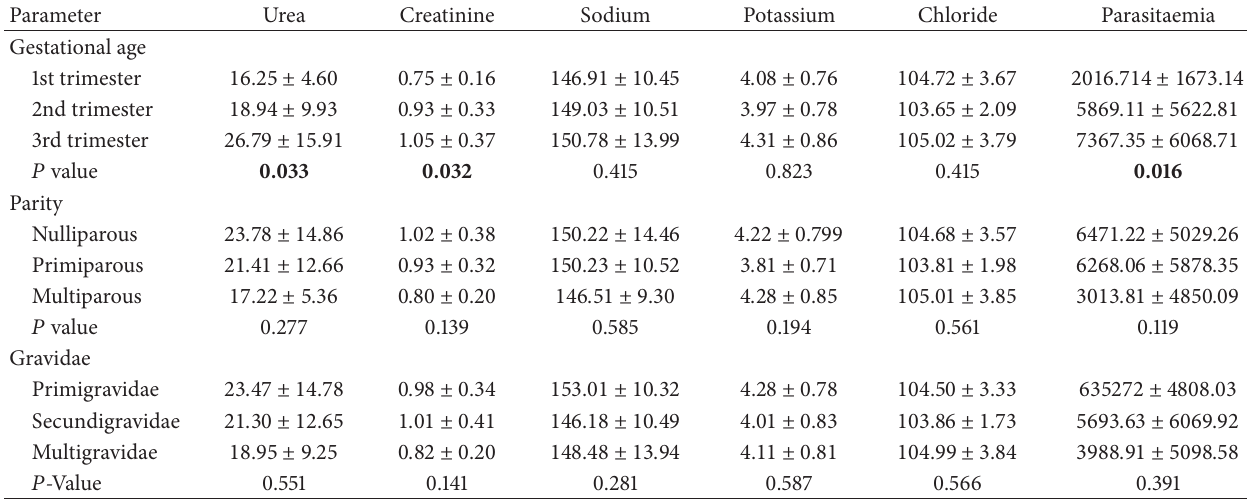
Table 3: Biochemical Parameters and degree of parasitaemia stratified by gestational age, parity, and